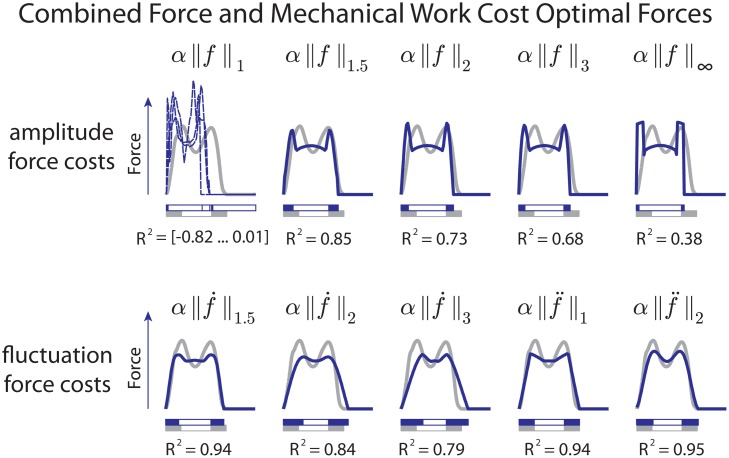
Vertical ground reaction force trajectories for various formulations of force cost J
f (Equation 3).Examples show the effect of varying the derivative order n and norm exponent p. Values for α were chosen to qualitatively match human forces where possible. The values for α in the cost function are (left to right), for amplitude force costs: [4.5 ⋅ 10−1, 5.0 ⋅ 10−1, 5.5 ⋅ 10−1], 5.0 ⋅ 10−2, 4.0 ⋅ 10−2, 4.5 ⋅ 10−2, and 2.0 ⋅ 10−2, and for fluctuation force costs: 2.7 ⋅ 10−3, 1.5 ⋅ 10−2, 2.3 ⋅ 10−2, 1.1 ⋅ 10−4, and 1.6 ⋅ 10−3.